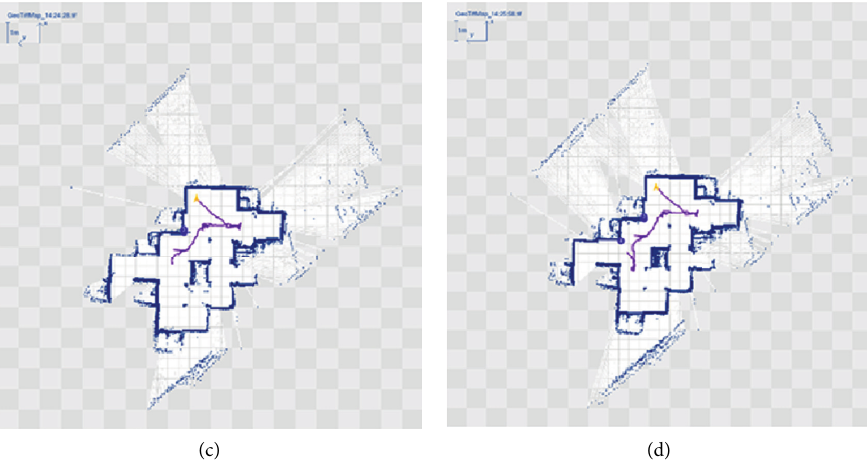
Figure 17: Mapping result and autonomous navigation route (China robot competition). (a) 1, (b) 2, (c) 3, (d)